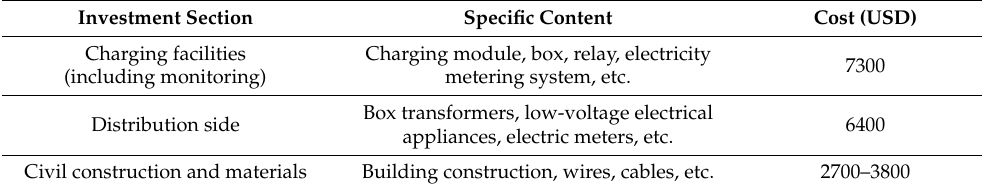
Table 4. Cost analysis of 100 kW DC charging